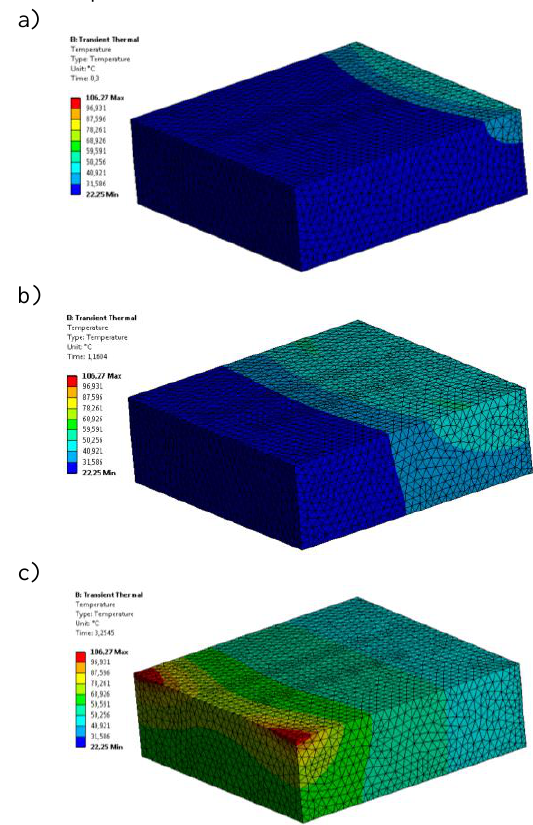
Fig. 8. Temperature changes in time, a) t=0.3[s], b) t=1.16[s], c) t=3.25